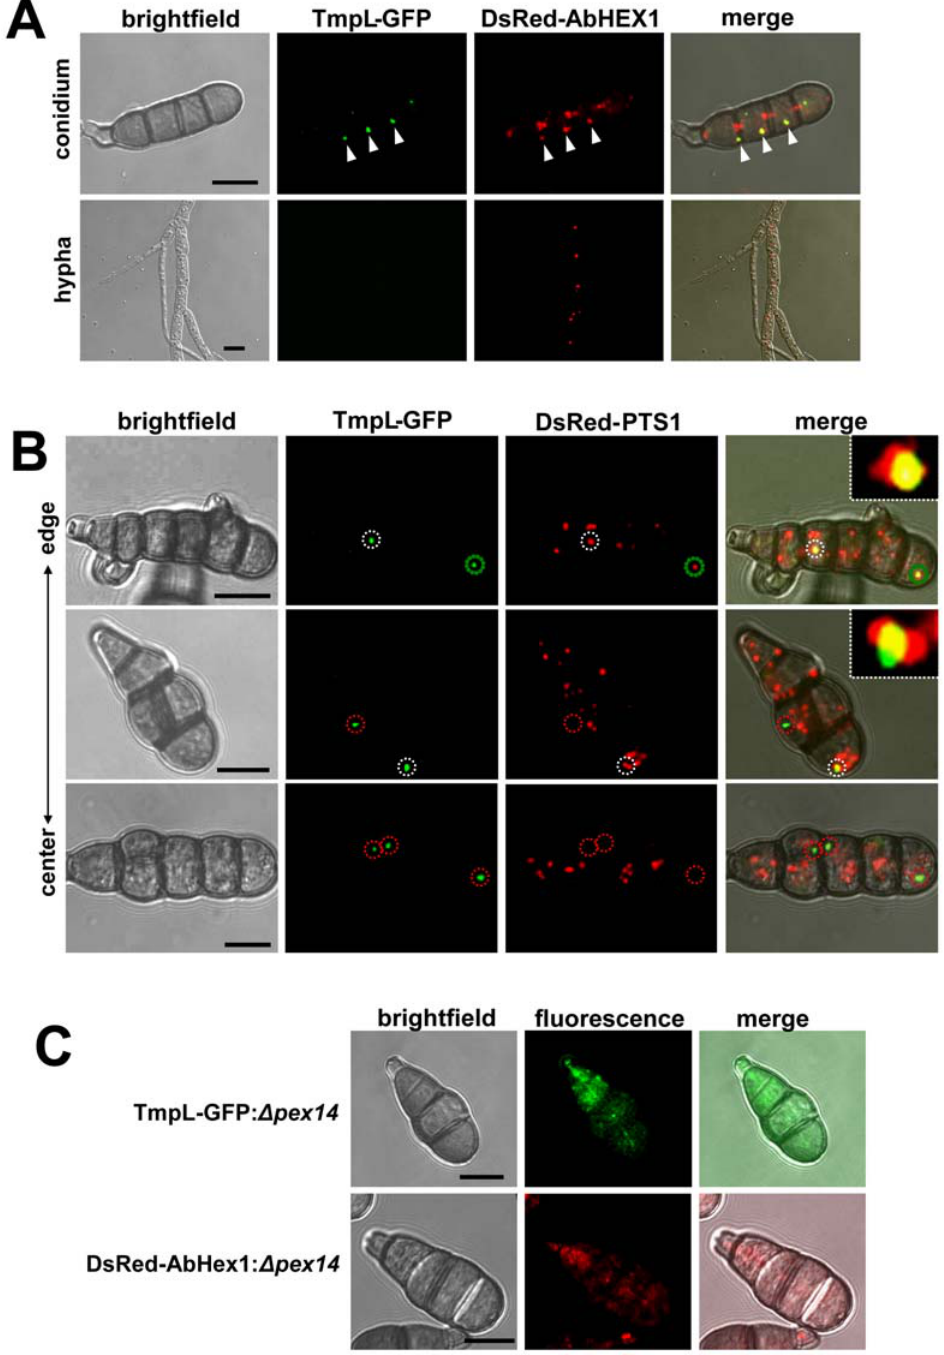
Figure 2. Subcellular distribution of TmpL-GFP fusion protein. ( A ) Co-localization analyses with a TmpL-GFP and DsRed-AbHex1 double- labeled strain in an A. brassicicola conidium (upper panel) and vegetative hypha (lower panel) were examined using confocal microscopy. TmpL-GFP localizes over cell cortex-associated or cytoplasmic DsRed-AbHex1 signals (arrowheads), not the septal pore-associated signals. Note that no TmpL- GFP signal is observed in the growing vegetative hyphae. Bars=10 m m. ( B ) Co-localization analyses with a TmpL-GFP and DsRed-PTS1 double-labeled strain in A. brassicicola conidia. DsRed-PTS1 fluorescence reveals peroxisomes. A large peroxisome is completely associated with TmpL-GFP signal (a green dotted circle, top panel). The other circles denote a partial association between TmpL-GFP and DsRed-PTS1 signals (white dotted circles, top and middle panels) and a complete dissociation of TmpL-GFP with DsRed-PTS1 signals (red dotted circles, middle and bottom panels). Note that different conidial age determined by collected sites, from the center to the edge of fungal colony, shows different types of association between two fluorescence signals. Insets indicate a magnified view of each white dotted circle representing a partial association between TmpL-GFP and DsRed- PTS1 signals. Bars=10 m m. ( C ) Localization analyses with D pex14 mutants on a background of either a TmpL-GFP or DsRed-AbHex1 strain. Note that the deletion of pex14 resulted in cytoplasmic redistribution of TmpL-GFP and DsRed-AbHex1 fluorescence signals. Bars=10 m m.